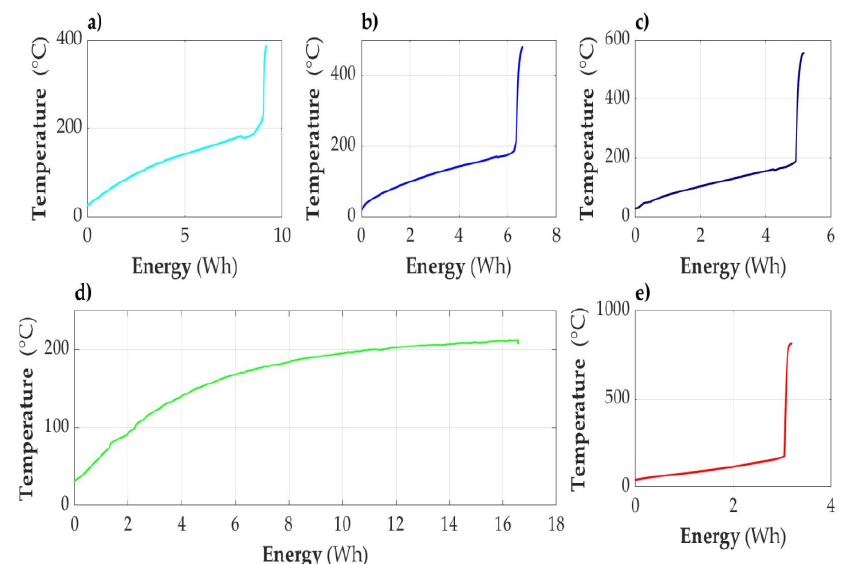
Figure 11. The dependence of the cell temperature on the energy supplied to the cell module. (Energy supply power—constant and equal to 9 W for all cells). ( a ) Cell partially discharged (SOC = 30%). ( b ) Cell partially discharged (SOC = 50%). ( c ) Cell fully charged (SOC = 100%). ( d ) Unloaded cell (SOC = 0%). ( e ) Cell overcharged (SOC > 100%).